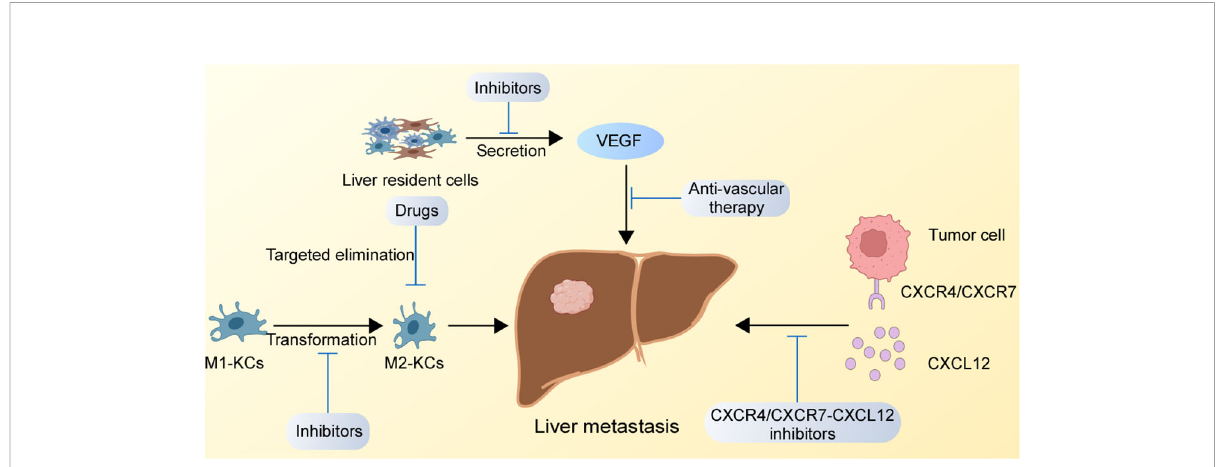
FIGURE 2 Potential therapeutic targets for GC liver metastasis. The inhibition of the CXCR4/CXCR7-CXCL12 axis in the liver, suppression of M1-type KCs to M2-type KCs conversion, and blockade the binding of receptors secreted by liver resident cells binding to receptors on GC cells might destroy the TME of liver